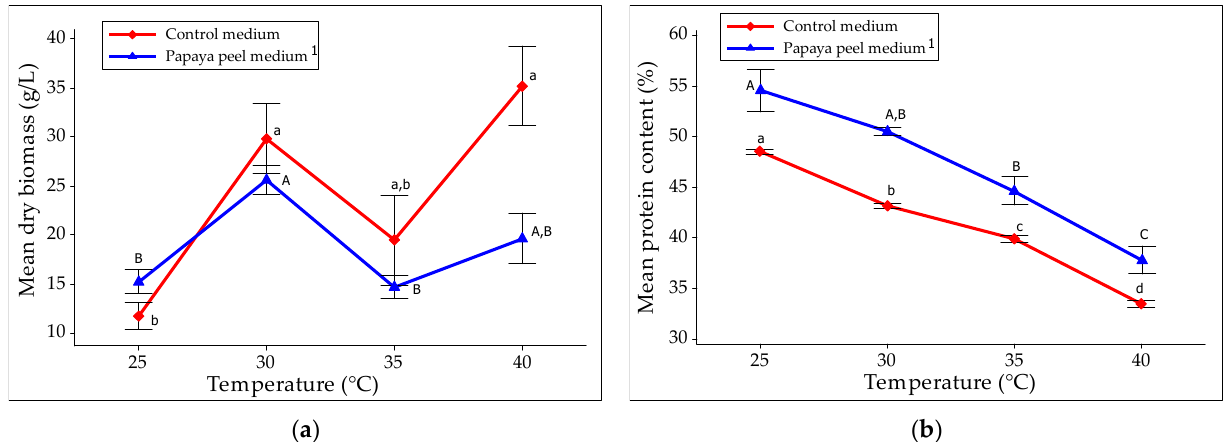
Figure 3. Effect of fermentation temperature on dry biomass and protein content of SCP produced from papaya peel and control media using mixed culture of palmyrah toddy in liquid state fermentation at 100 rpm with 10% ( v / v ) substrate concentration at pH 5.0 for 72 h: ( a ) Effect of fermentation temperature on dry biomass; ( b ) Effect of fermentation temperature on the protein content. Comparisons of mean were performed with Tukey’s multiple comparison test at p < 0.05. Different uppercase and lowercase letters indicate the significant differences in papaya peel medium and control medium, respectively [58].